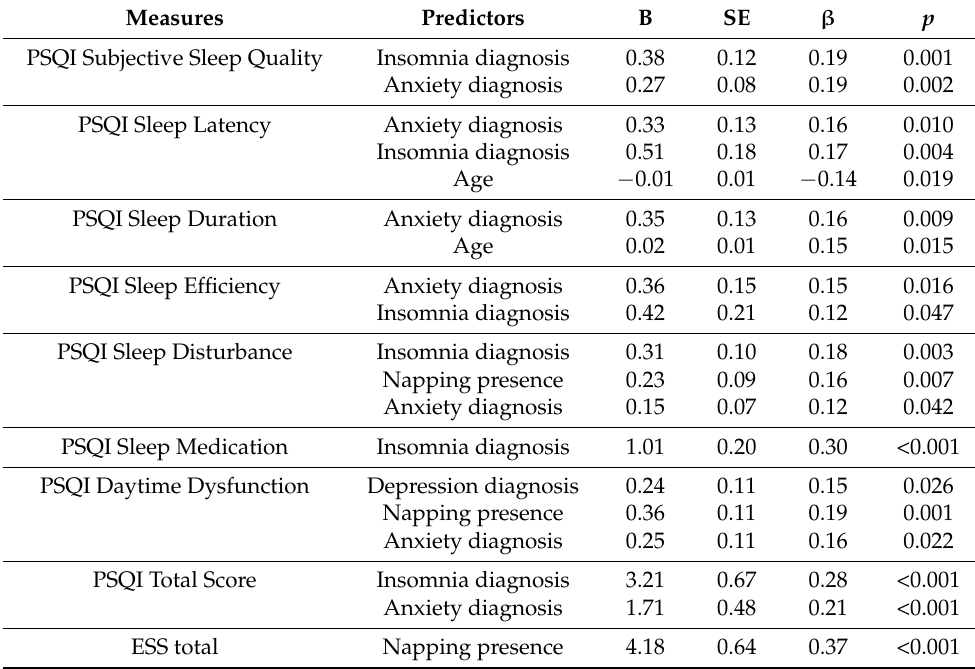
Table 5. Significant predictors and coefficients from regression